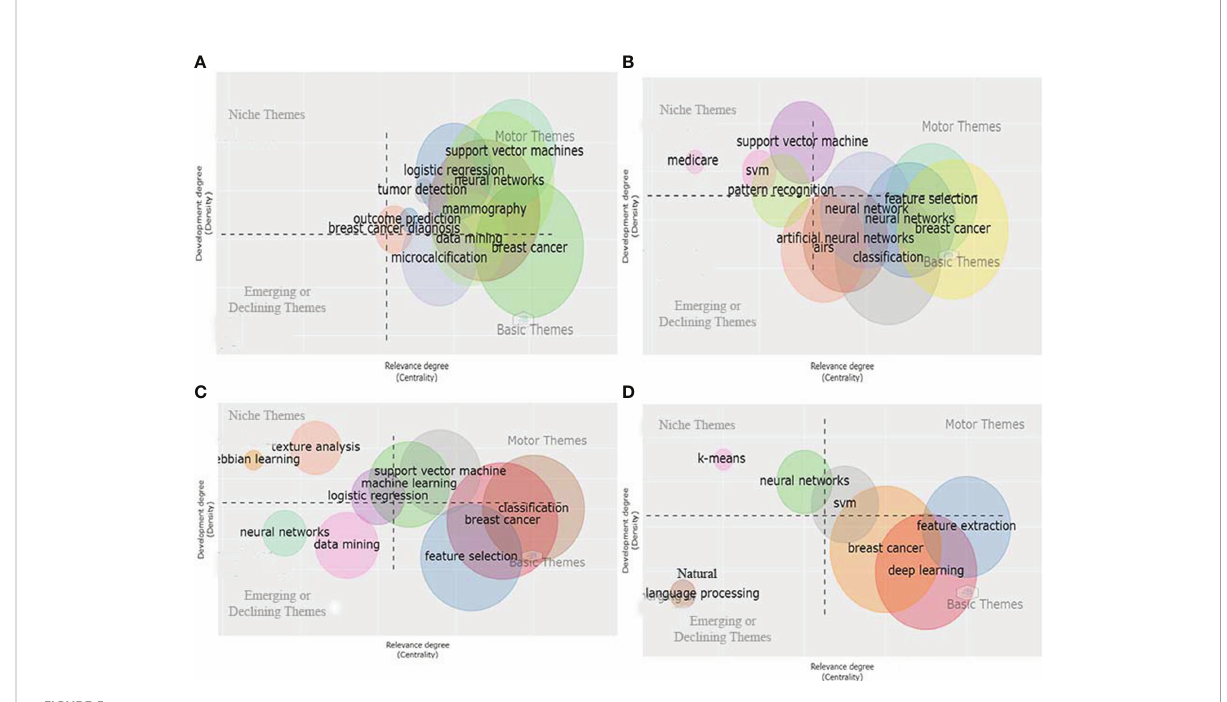
FIGURE 5 (A – D) Sankey diagram based on keyword thematic evolution from 2000 to